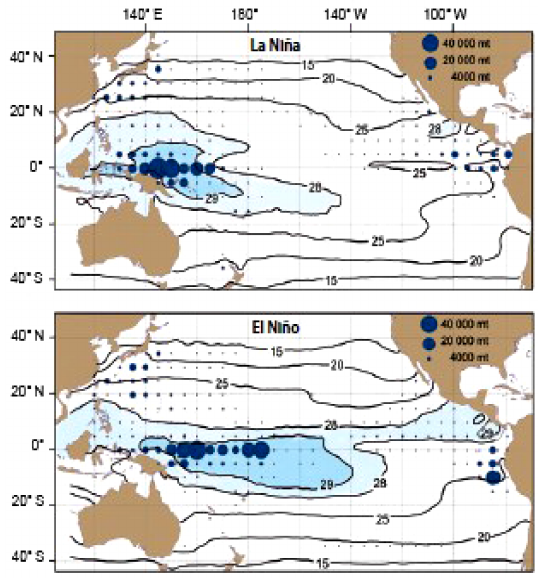
Figure 1. Skipjack tuna (metric tons) catches under la Niña and El Niño events. Sea surface temperatures in centigrade ( ◦ C). After WWF (2013). Catch load in metric tons (blue